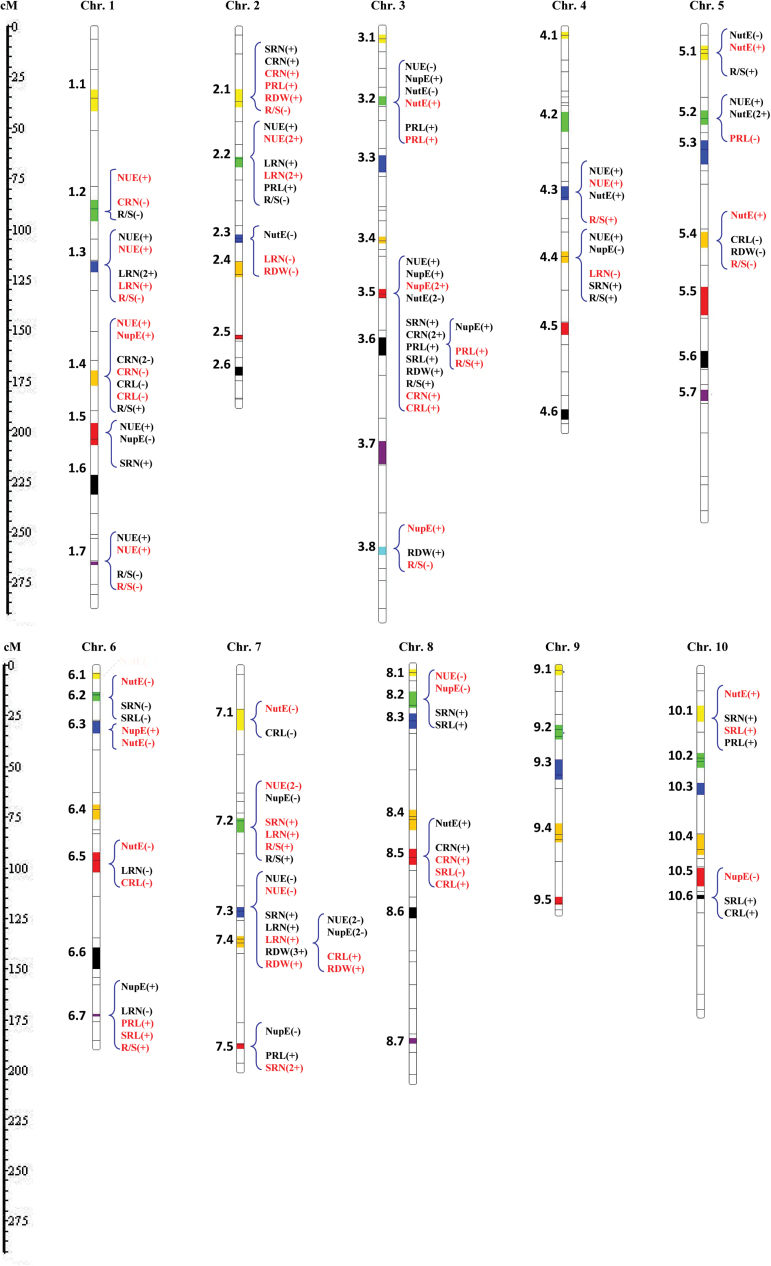
Location of the QTL clusters detected for all investigated traits as revealed by meta-QTL analysis. A vertical column represents each maize chromosome (chr) with the marker intervals where the QTL cluster was located. Each coloured boxplot represents the identified QTL cluster across all chromosomes. The name of each QTL cluster is give on the left of the chromosome. The QTLs contained within this cluster are given on the right of the chromosome. The names of the QTLs in the specific clusters are presented in which QTLs for NUE-related traits (NUE, NupE, and NutE) and QTLs for RSA-related traits (CRN, CRL, SRN, SRL, PRL, LRN, RDW, and R/S) coincided. Those QTLs detected at HN levels are indicated in black, and at LN levels in red. The number between parentheses indicates how many experiments this QTL was detected in. Additionally, a positive (+) and negative (−) sign represent positive additive effects from Ye478 and Wu312, respectively.